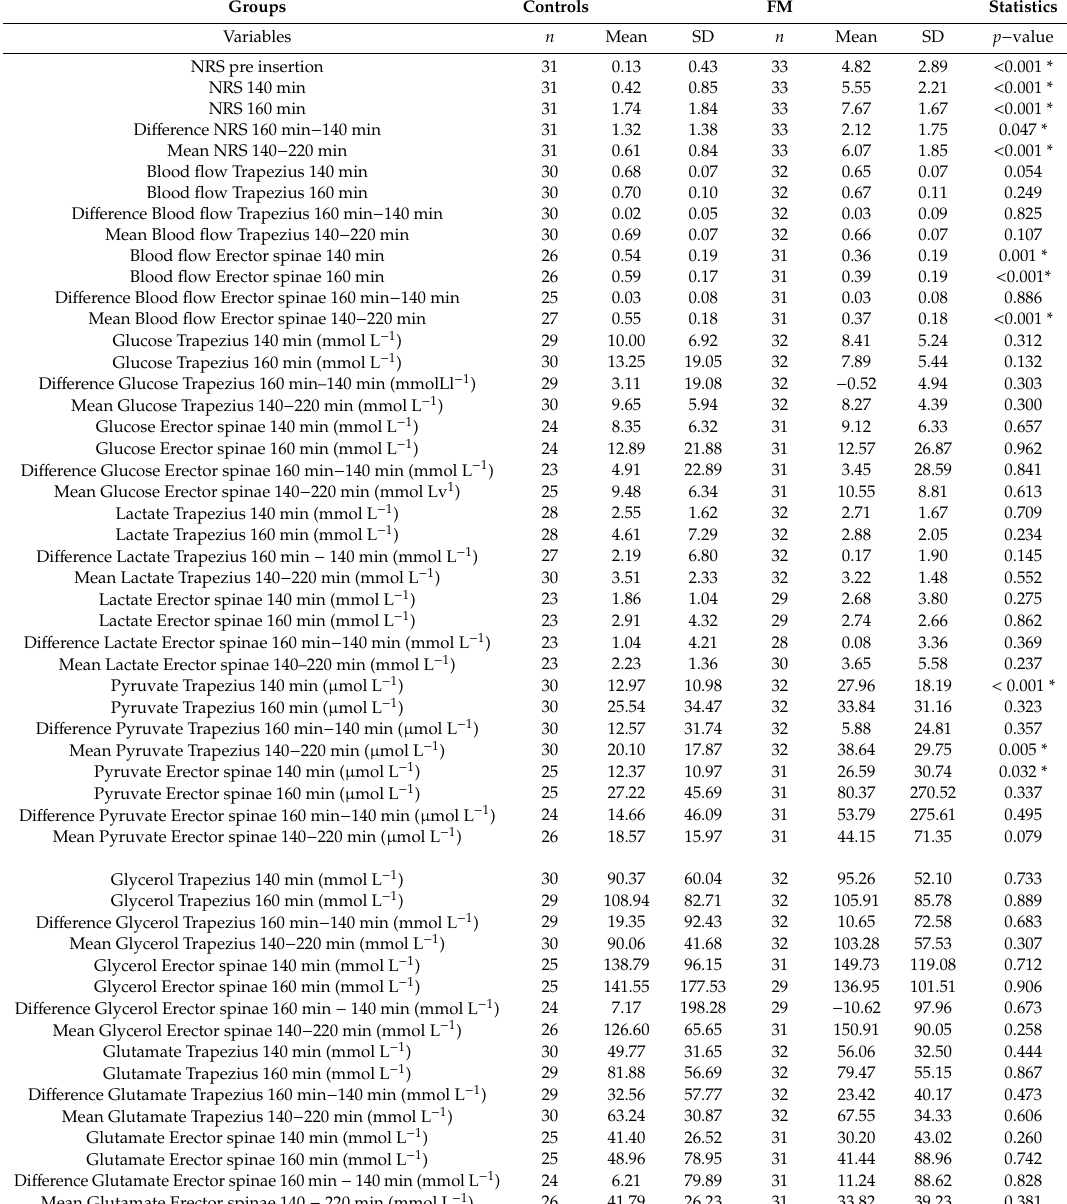
Table 3. Data obtained from the microdialysis of trapezius and erector spinae muscles.